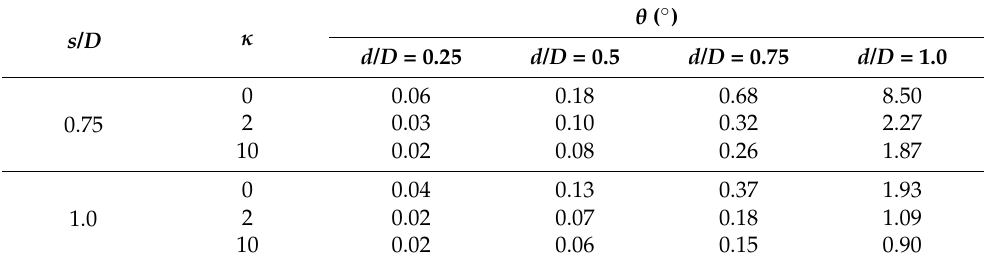
Figure 11. Horizontal capacities of tetrapod bucket foundations at κ = 10: ( a ) horizontal capacity factor, ( b ) horizontal group effect factor and ( c ) normalized horizontal group effect factor. Table 2. Rotation angles of tetrapod bucket foundations under uniaxial horizontal